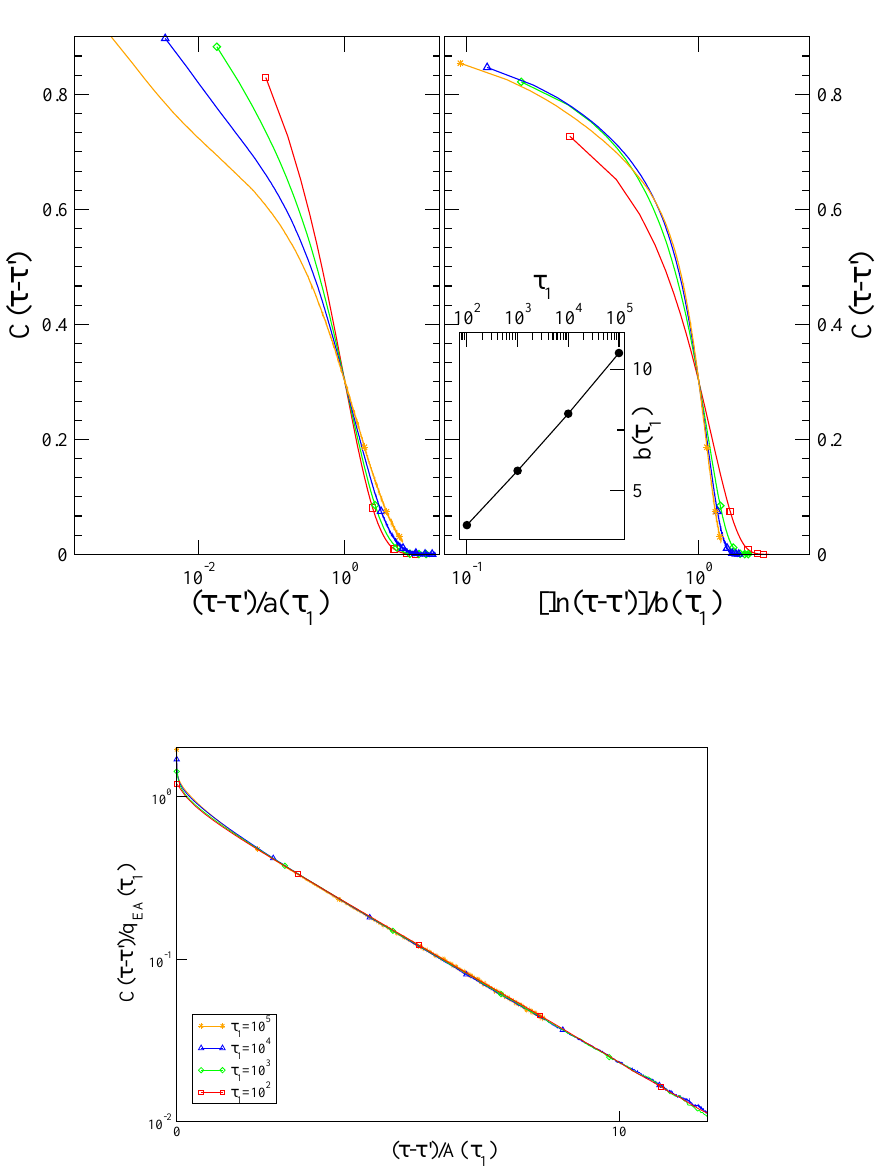
Figure 3: Three scalings for the autocorrelation function C ( τ , τ (cid:48) ) of the SK model with T = 1 / 2 and the coupling constants J multithermalized with T (cid:48) = ∞ ; and ij various timescales τ of the slow bath (see key in the lower panel). Stationarization 1 = 20 2 ,10 3 ,10 4 ,10 5 , respectively. is achieved by letting τ (cid:48) = 25,50,3000,3000 for τ 1 ) , where a ( τ ) is a fitting Upper left panel: C ( τ − τ (cid:48) ) is plotted against ( τ − τ (cid:48) ) / a ( τ 1 1 parameter adjusted so to collapse the curves at C ( τ − τ (cid:48) ) = 0.3. Upper right panel: ) , where b ( τ ) is adjusted to collapse C ( τ − τ (cid:48) ) is plotted against ln ( τ − τ (cid:48) ) / b ( τ 1 1 the curves at C ( τ − τ (cid:48) ) = 0.3 and is plotted in the inset on a log-linear plot (best fit ) = − 1.18 + 1.02 · ln τ ( τ ) plotted against yields b ( τ ). Bottom panel: C ( τ − τ (cid:48) ) / q EA 1 1 1 ( τ − τ (cid:48) ) / A ( τ ) on a linear-log scale, where A ( τ ) and q ( τ ) are fitting parameters EA 1 1 1 determined as to obtain data collapse among curves at their tails. The system size (cid:112) = ± 1 / N . All the curves are is N = 2 10 , the coupling constants are random J ij averaged over 4 · 10 4 − 2 · 10 5 realisations, for the various